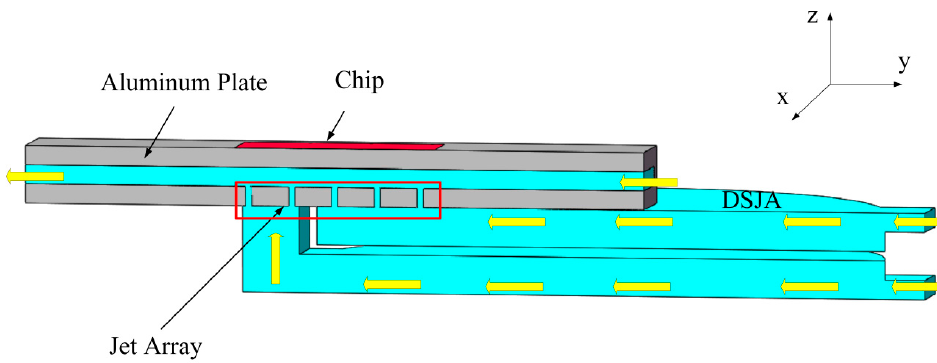
Figure 1. Schematic diagram of cooling device.